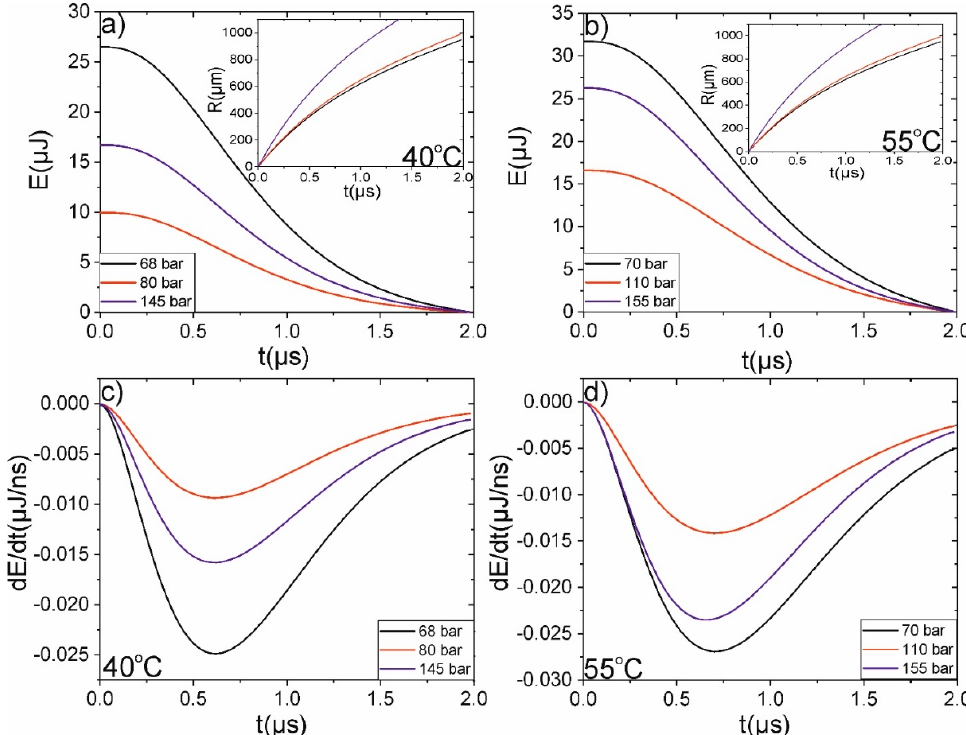
Figure 5. ( a , b ) Dependences of the shock wave energy and shock wave radius (see insets) on time delay for different pressures and temperatures. The insets show the evolution of the shock wave radius for different pressures. ( c , d ) Dependence of the energy decrease rates on time delay for different pressures and temperatures. The presented dependences are obtained from the numeric simulation based on the experimentally observed values of shock wave velocities and decay rates, using Equations (3)–(6).